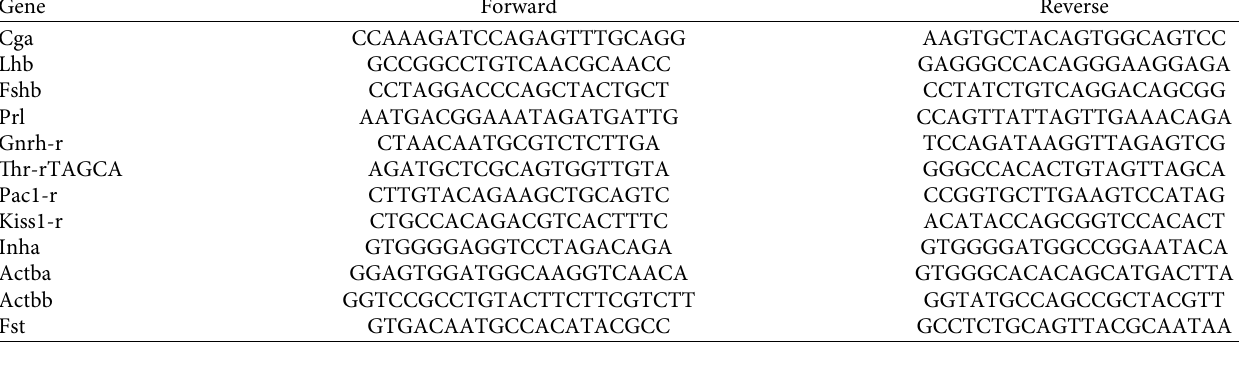
Table 1: Primer sequences used for measurement of gene expression using real-time quantitative PCR.